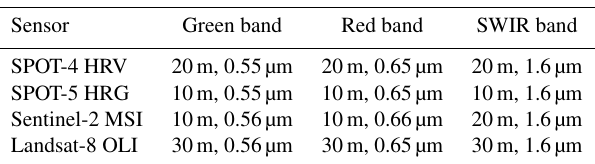
Table 2. Spatial resolution and central wavelength of the spectral bands used by LIS for each compatible